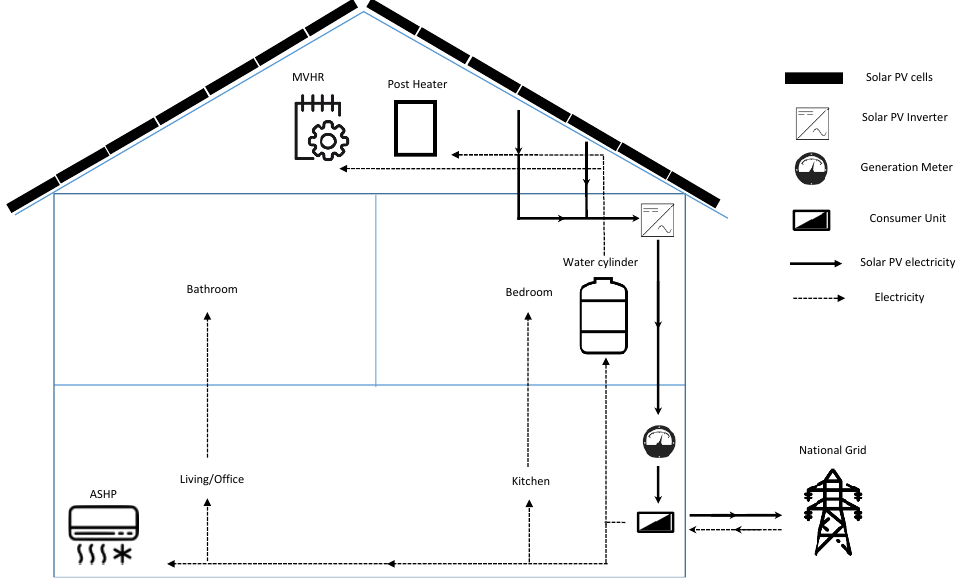
Figure 5. SIPs house with Solar PV installation.